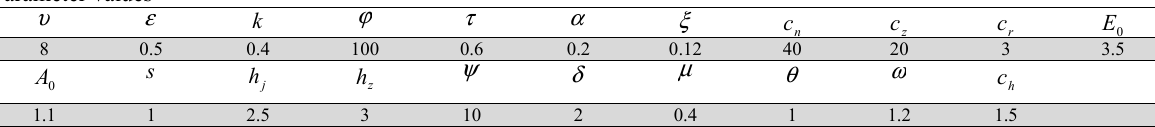
Parameter values